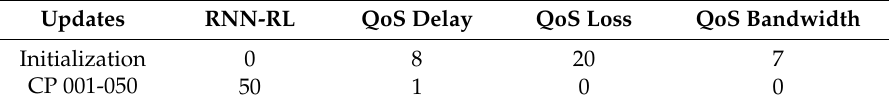
Table 17. Deep Learning Cluster vs RNN-RL (5 × 5 Nodes).